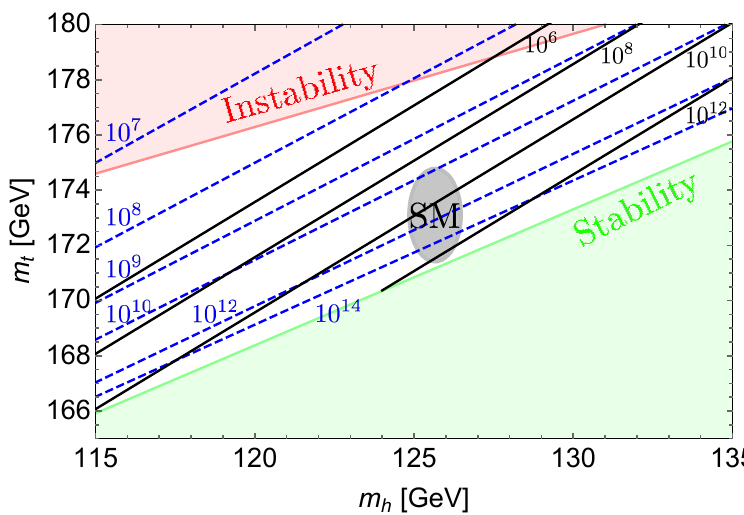
Figure 7 . The SOL prediction as a function of the Higgs and top-quark masses, for given values of H in GeV (black lines), alongside the absolute stability (green) and instability (red) regions, 0 as calculated in ref. [82]. Also shown is the 95% CL ellipse corresponding to the SM values. The dashed blue lines show the Higgs field value (in GeV) at which the effective potential vanishes and therefore, for M equal to the same value, the IR and UV vacua are exactly